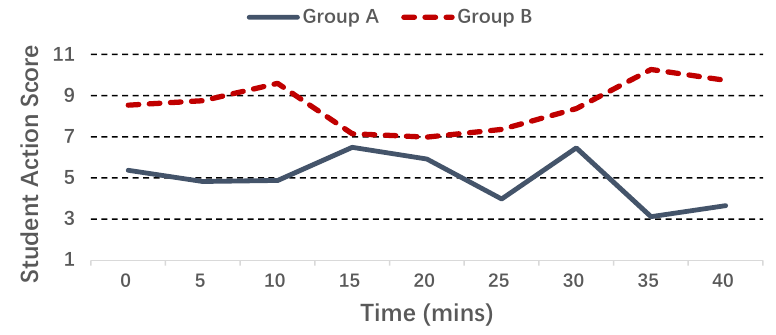
Figure 9. Average student action score of two groups.